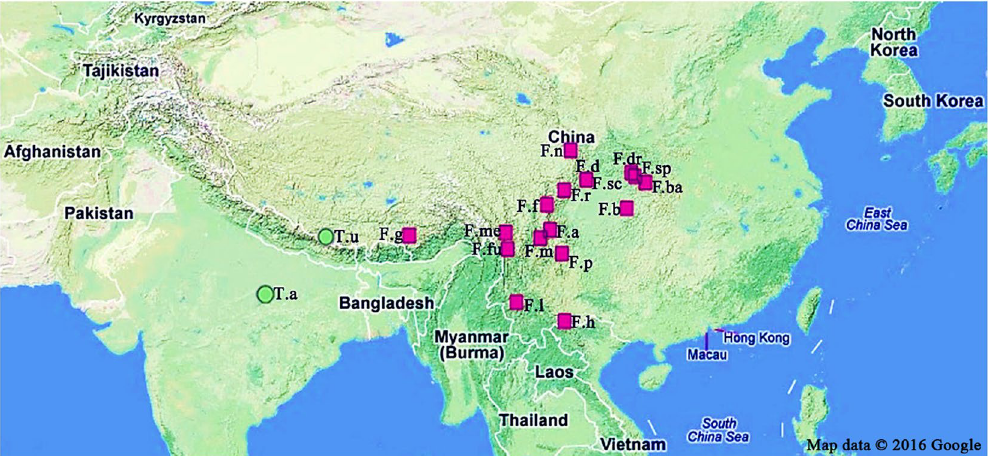
Figure 4. Geographic distribution of accessions of Fargesia and Thamnocalamus species used in this study. Red squares represent Fargesia species, and green circles indicate Thamnocalamus species. Please see Table 1 for details. The figure was generated with Adobe ® Photoshop ® CS3 extend 10.0.1 software (Adobe Systems Inc., San Jose, CA, USA; URL link: https://www.adobe.com/products/photoshop.html ? promoid = KLXLS) based on Google ® maps (Google Inc., Mountain View, CA, USA; URL link: